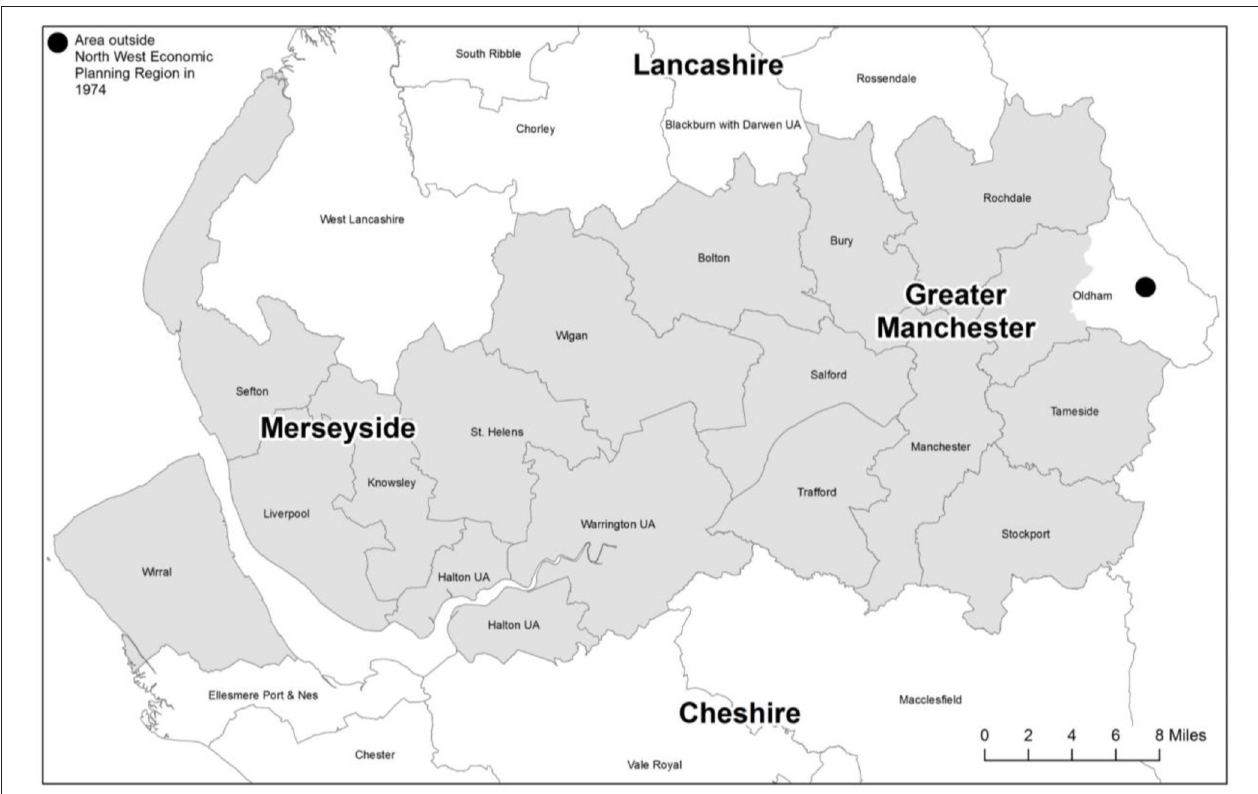
FIGURE 1 | The Mersey Belt in the North West UK. Map drawn by Nick Scarle, University of Manchester. Shaded areas are those local authority areas considered to be in the Mersey Belt in 1974.